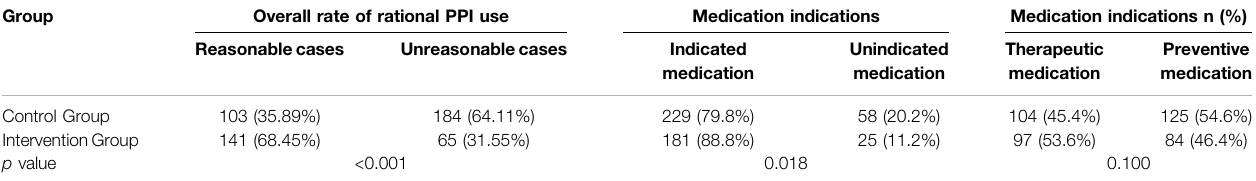
TABLE 3 | Comparison of overall rational PPI use rate and medication purposes.